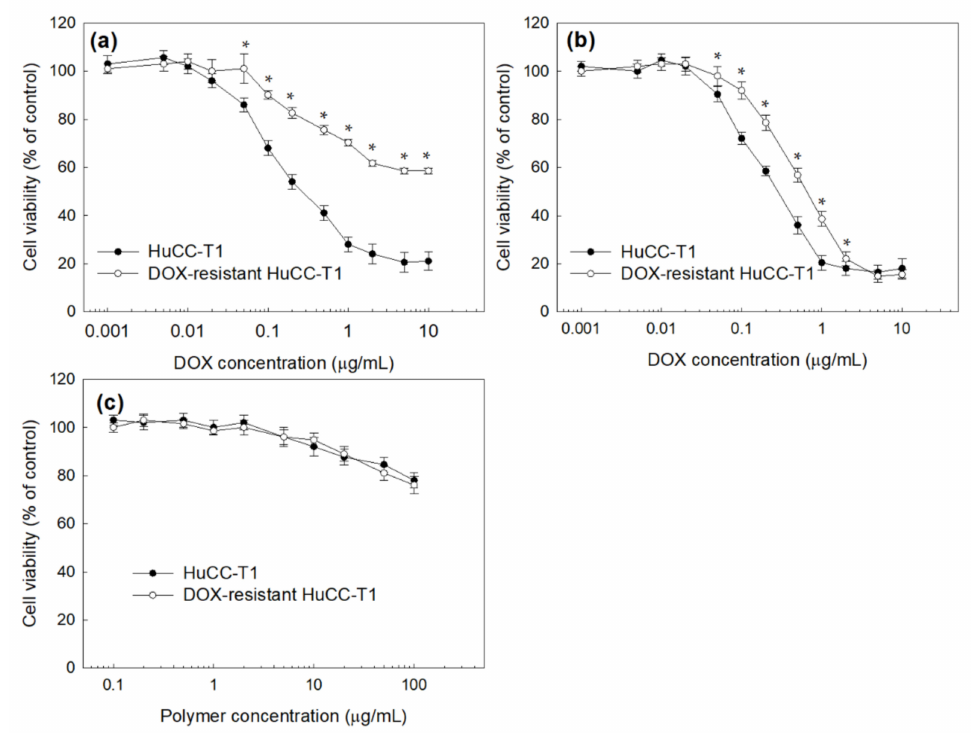
Figure 6. Cell cytotoxicity of DOX or DOX-incorporated ChitoHISss nanoparticles against HuCC-T1 cells and DOX-resistant HuCC-T1 cells. ( a ) DOX; ( b ) DOX-incorporated ChitoHISss nanoparticles; ( c ) empty nanoparticles. Each measurement was the average ± standard deviation (S.D.) from eight wells of 96-well plates. * indicates comparison between HuCC-T1 and DOX-resistant HuCC-T1. ANOVA followed by Tukey test, p <